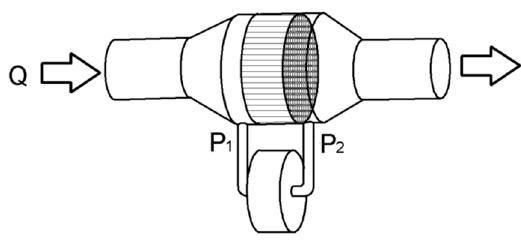
Figure 2. Drawing of a Fleisch pneumotachograph showing the individual components. Electronics 2020 , 9 , 275